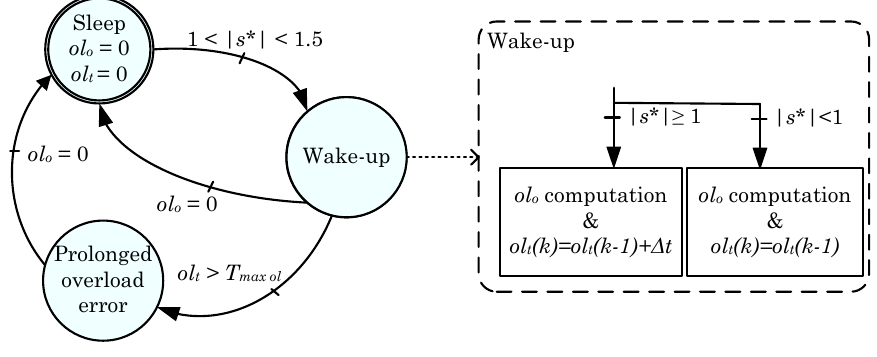
Figure 6. Scheme of the power over-load supervisor